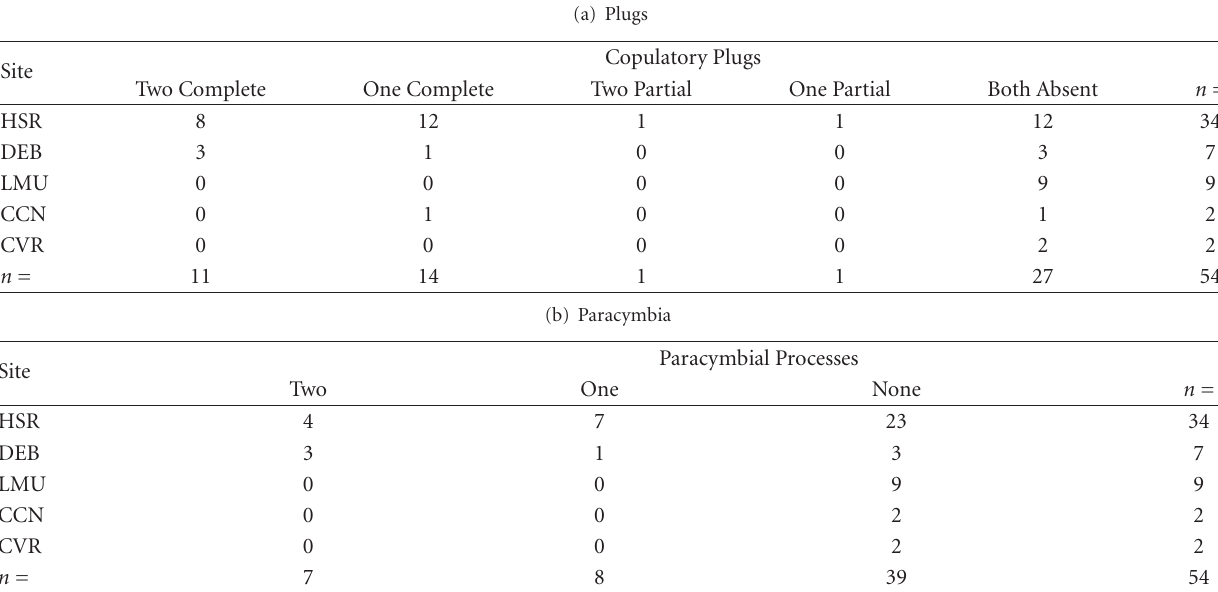
Table 4: Combinations of copulatory plugs and paracymbial processes in the epigyna of field-collected Peucetia viridans females by sample site. Site abbreviations are defined in the